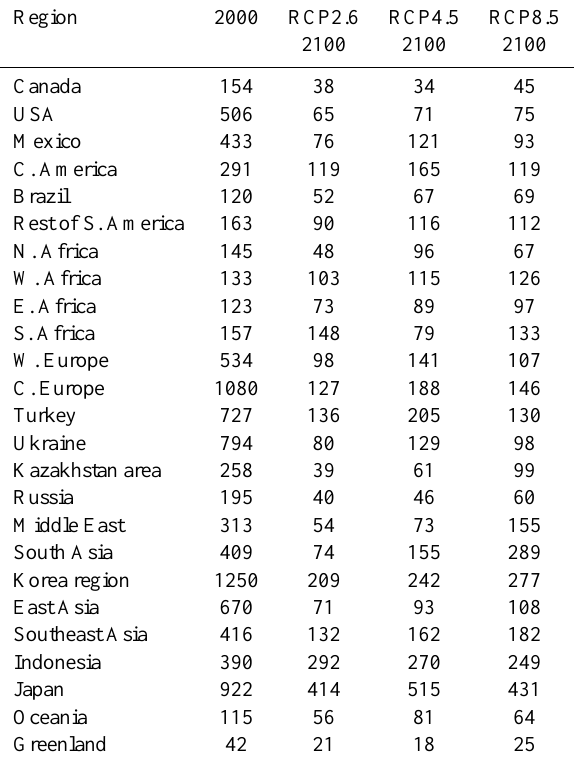
Table 8. Average MMM sulfur deposition (mg(S)m − 2 yr − 1 ) over specific regions as defined in Lamarque et al. (2011). The deposition does not increase in any of these regions with respect to